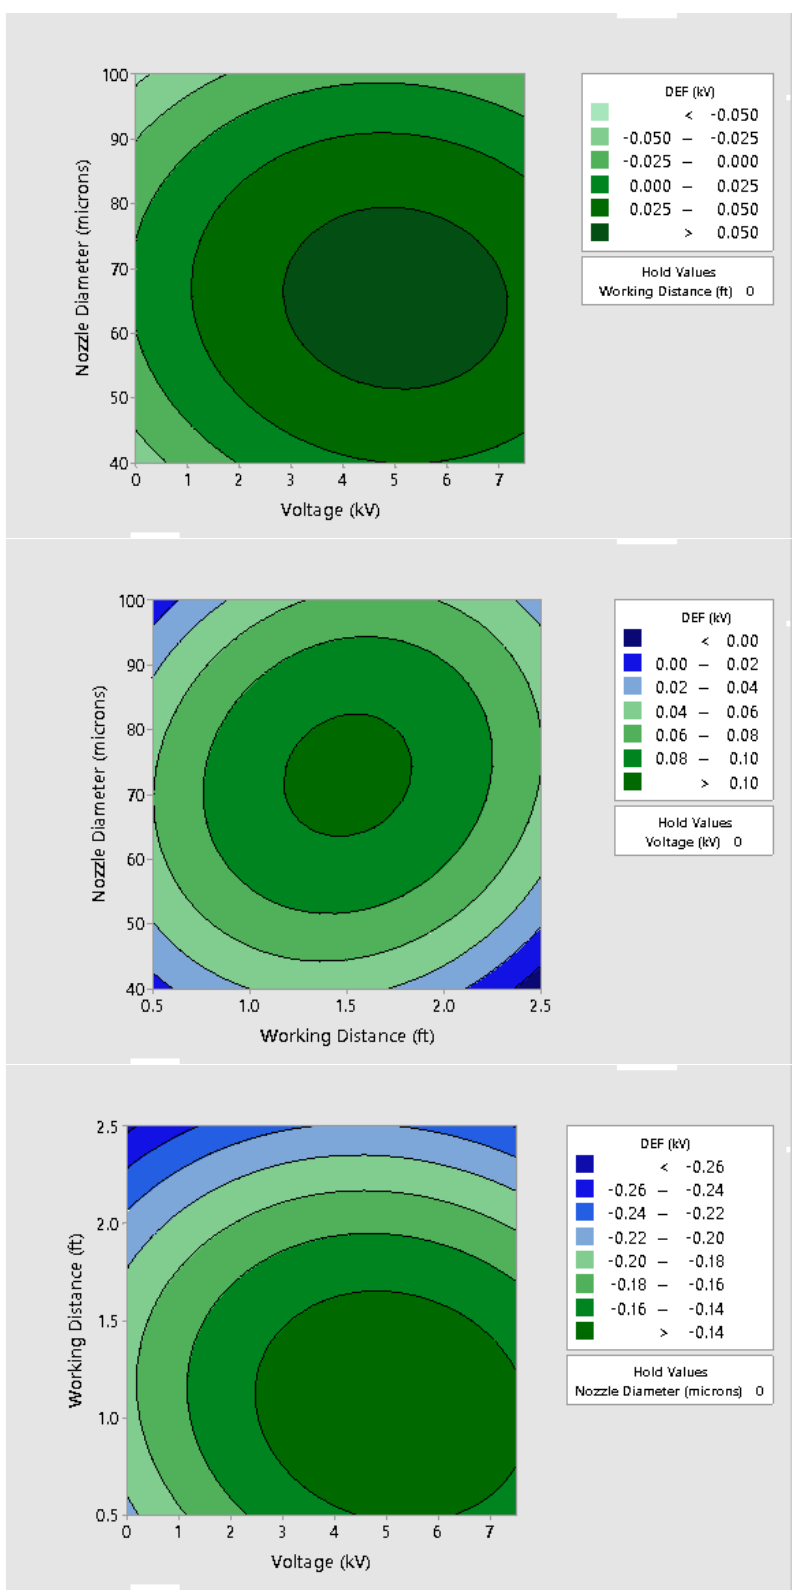
Figure A30. Aircraft sample-2: quantitative representation of average differential electric field vs. working distance (feet), nozzle sprayer size ( µ m), and charge voltage